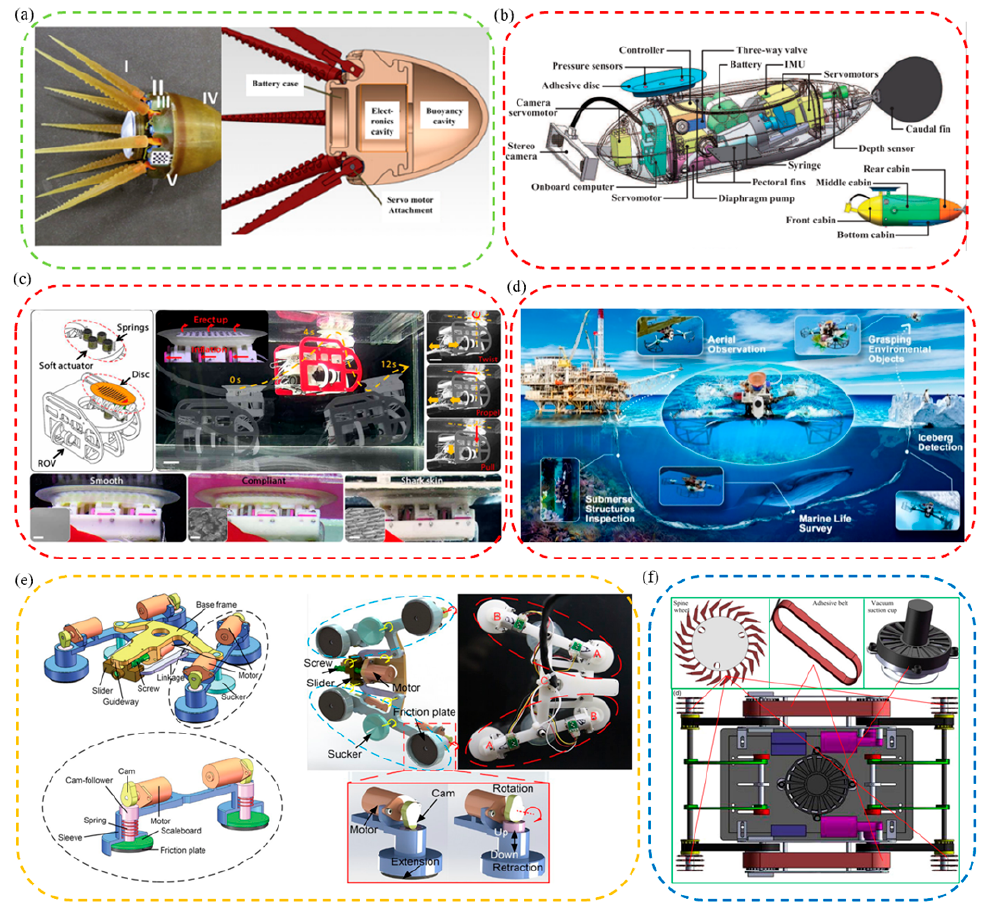
Figure 4. Bionic robots inspired by aquatic organisms. ( a ) A compliant eight-arm robotic prototype with PU arms (reproduced with permission from [110], IOP Publishing Ltd., Copyright 2015). ( b ) A mechatronic design of a robotic remora (reproduced with permission from [111], IEEE, Copyright 2021). ( c ) A biomimetic suction disc inspired by the remora. It can hitchhike underwater (reproduced with permission from [21], Wang Yueping et al., Copyright 2017). ( d ) A depiction of the mission profile and design of an aerial − aquatic hitchhiking robot. It can cross water and air and attach robustly to a wide variety of surfaces and perform long-term missions (such as monitoring) in nat- ural environments (reproduced with permission from [22], Li Lei et al., Copyright 2022). ( e ) A rock- climbing fish-inspired robot crawling with load bidirectionally (reproduced with permission from [23], Zhejiang University Press, Copyright 2022). ( f ) A biomimetic motion and wall − climbing robot model (reproduced with permission from [112], Cambridge University Press, Copyright 2020).